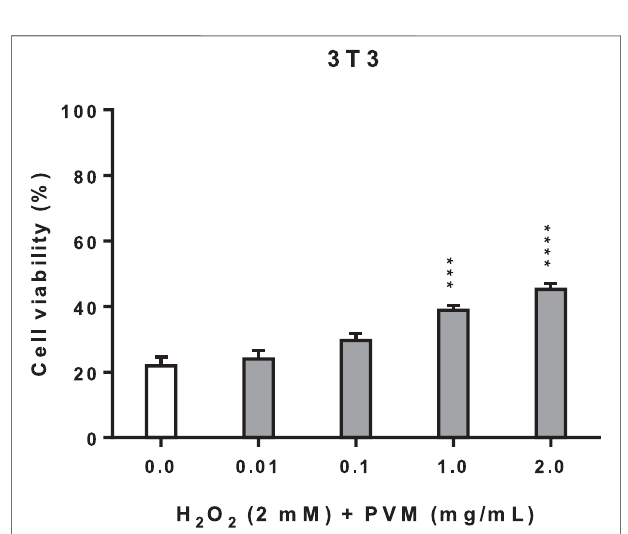
FIGURE 4 | Cellular repair activity of PVM in 3T3 cell line for 2 mM H 2 O 2 during 2.5 h by MTT assay and expressed as percentage of cell viability respect to untreated cells control. H 2 O 2 cell viability was used as positive control.Results areexpressed asmean ± standarderrorof n (cid:2) 3.Atwo- way analysis of variance (ANOVA) and a Bonferroni post hoc assay have been performed. Statistical differences were considered as follows: *** p ≤ 0.001 and **** p ≤ 0.0001 compared with positive